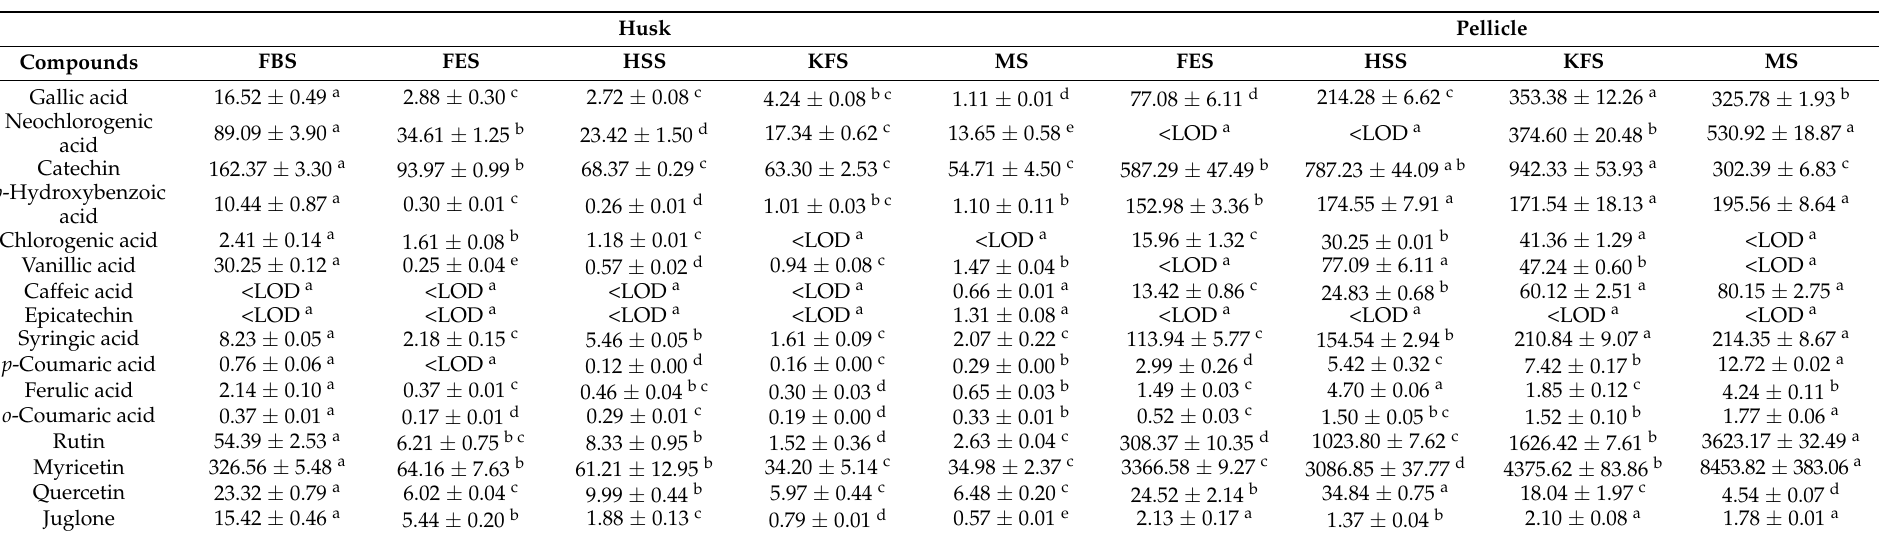
Table 3. The contents of 16 polyphenols in walnut husk and pellicle during development by HPLC. Husk